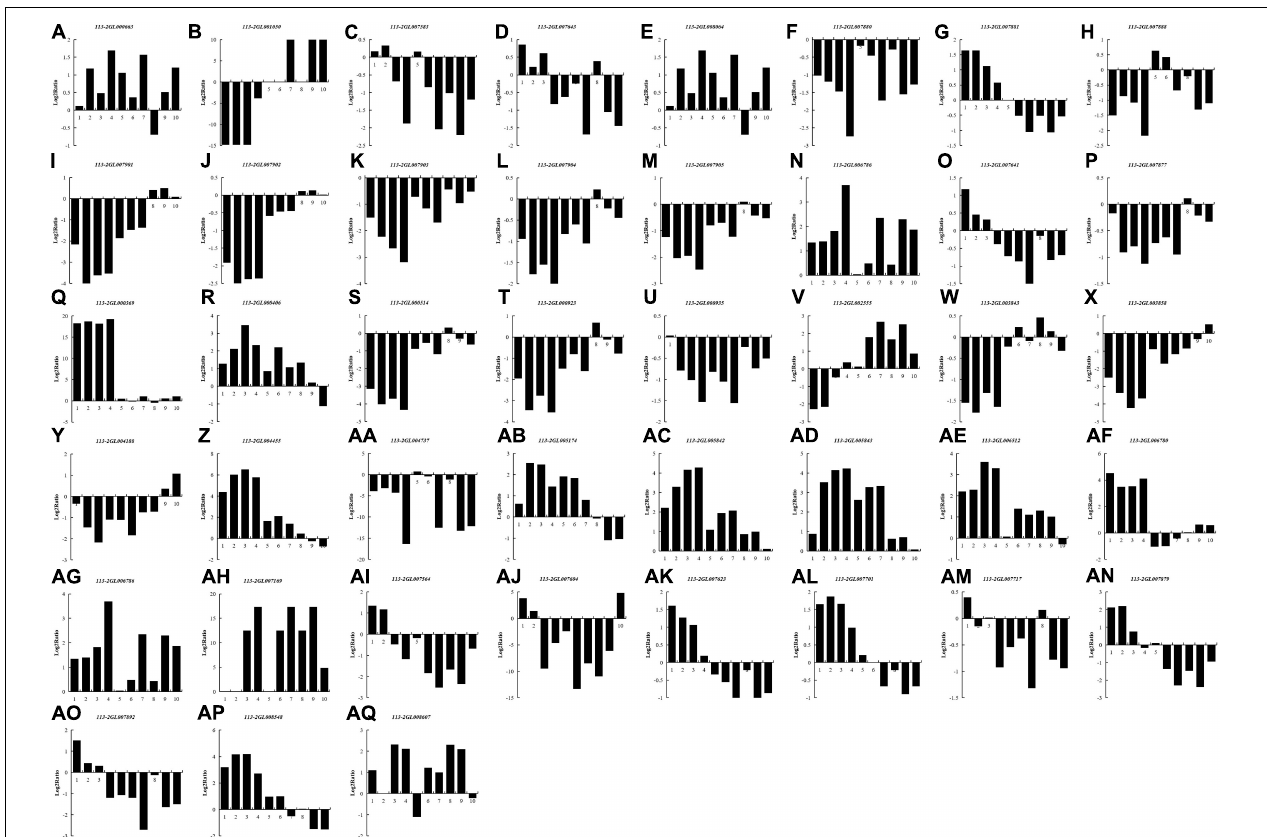
FIGURE 7 | The Log2Ratio values of the DEG encoding Nod-related genes and T3SS secretion system-related genes during nodule development and senescence. Nod genes: (A–E) ; Nif genes: (F–M) ; Fix genes: (N–P) ; T3SS-related genes: (Q–AQ) . 1, branching stage vs. flowering stage; 2, branching stage vs. fruiting stage; 3, branching stage vs. pod stage; 4, branching stage vs. harvest stage; 5, flowering stage vs. fruiting stage; 6, flowering stage vs. pod stage; 7, flowering stage vs. harvest stage; 8, fruiting stage vs. pod stage; 9, fruiting stage vs. harvest stage; 10, pod stage vs. harvest